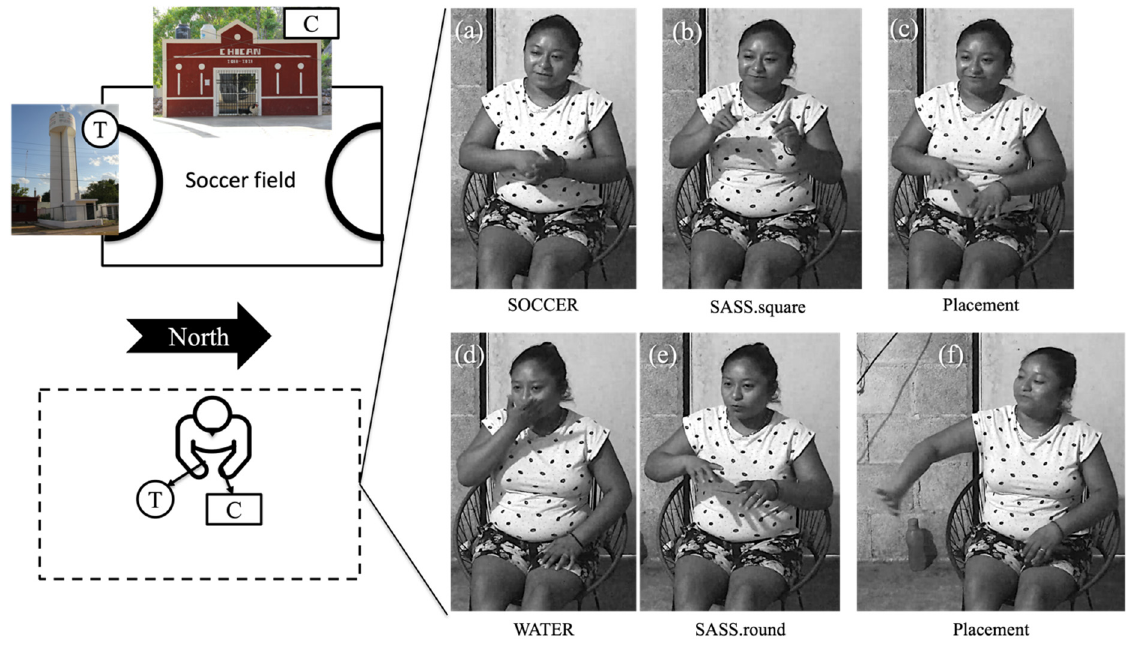
Figure 10. Spatial localization using the geocentric FoR, in placing the entities in the signing space according to their real-world orientation (on the left are diagrams that represent the array of objects and the signers and the signing area as viewed from above). “The soccer field (= comisaria ) ( a , b ) is here ( c ), and the water tank ( d , e ) is there (=south of the comisaria ) ( f )” (Deaf signer form second generation of Chicán).